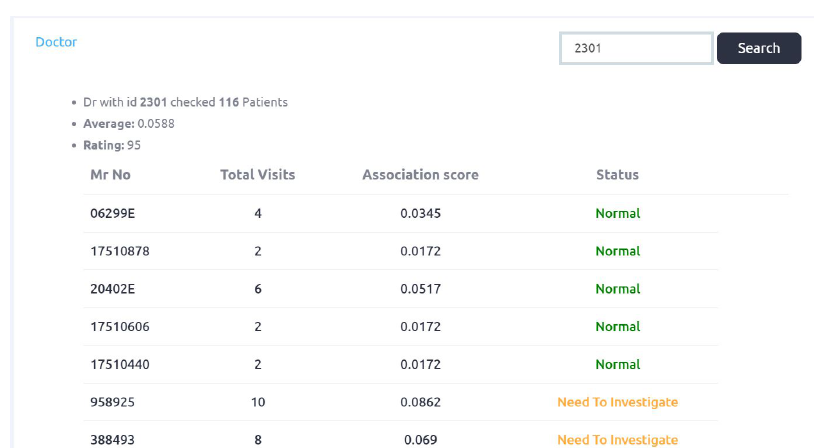
Figure 15. Doctor_id 2301 initial rating in First phase.